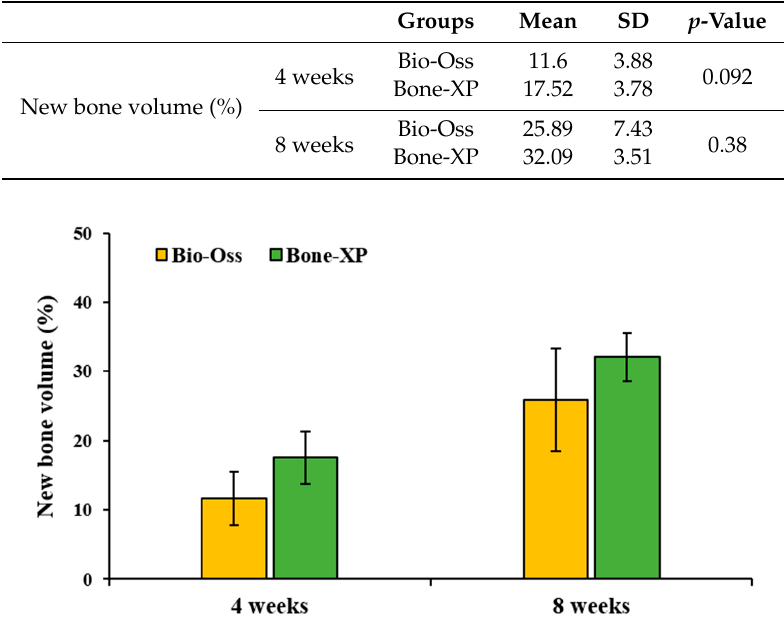
Figure 9. New bone volume percentages within area of interest (AOI).